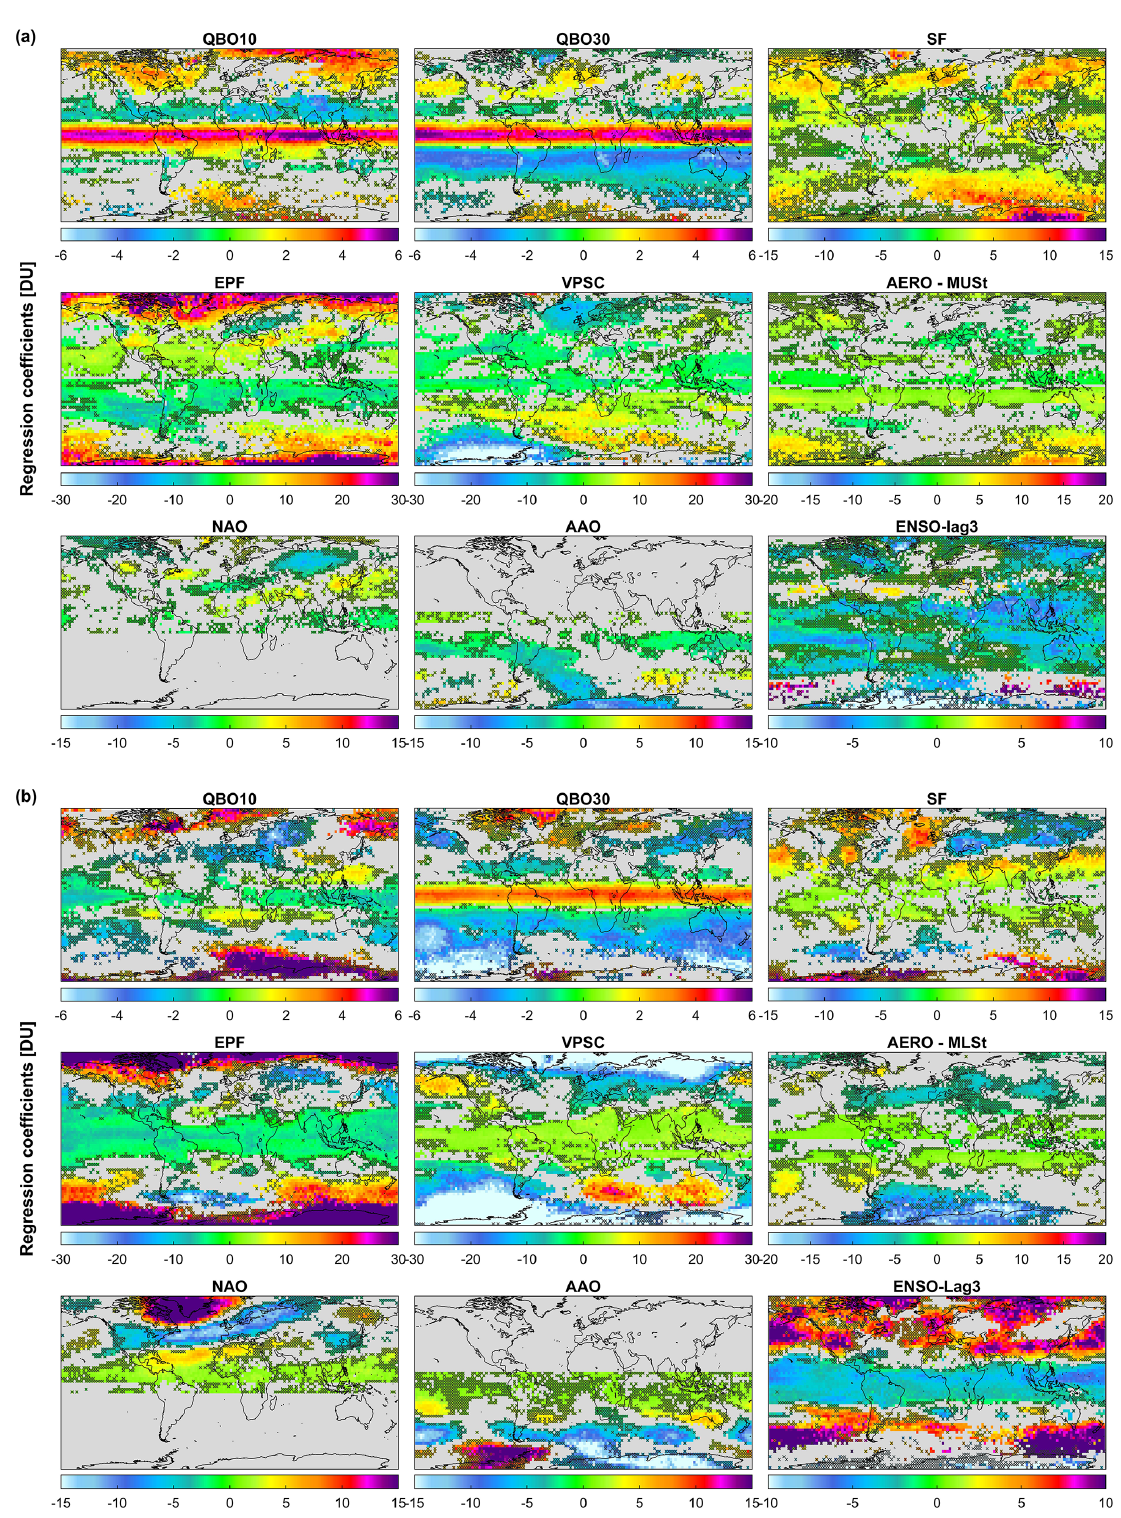
Figure 5. Global distribution of the annual regression coefficient estimates (in DU) for the main O 3 drivers in (a) MUSt and in (b) LSt: QBO10, QBO30, SF, EPF, VPSC, AERO, NAO, AAO and ENSO (ENSO-lag3 for both LSt and MUSt). Grey areas and crosses refer to non-significant grid cells within the 95% confidence limit. Note that the scales differ among the